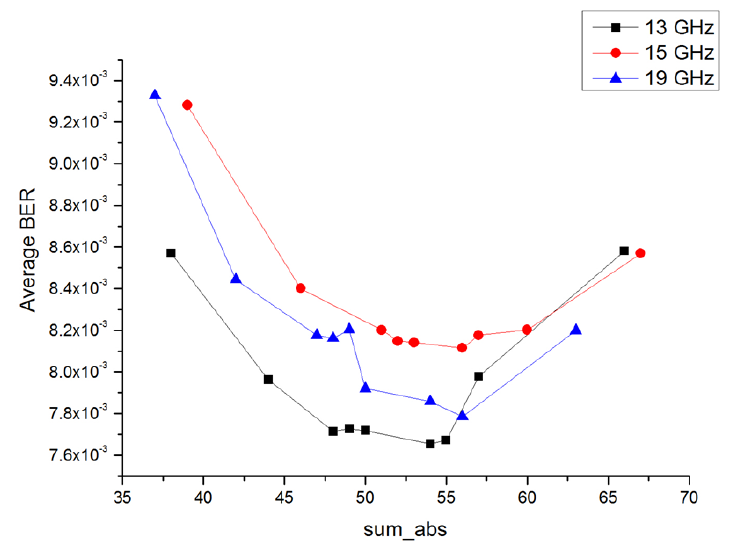
Figure 6. The direct current (DC) gain of the FIR filter should be optimized to minimize the bit error ratio (BER).